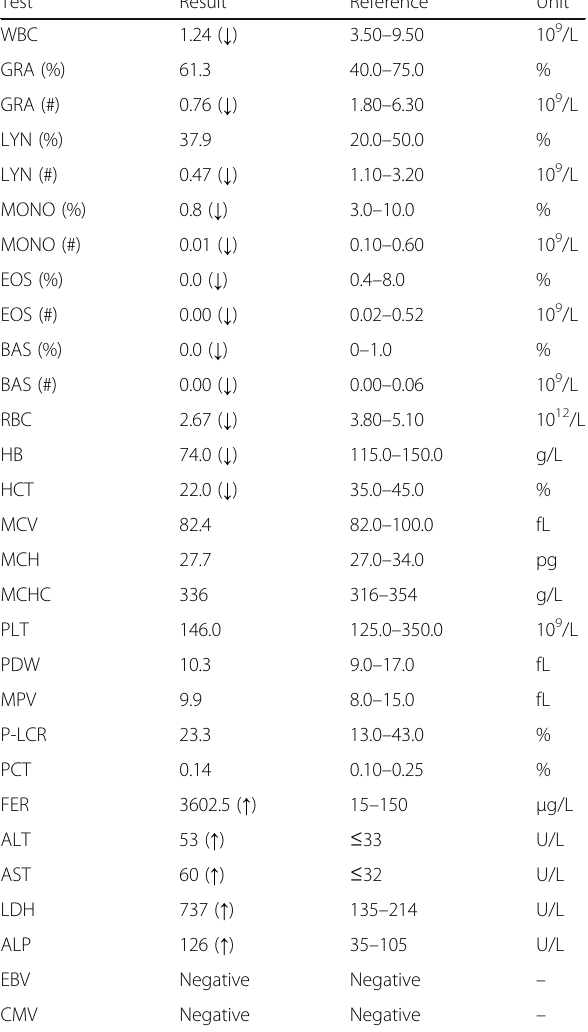
Table 1 Laboratory test results